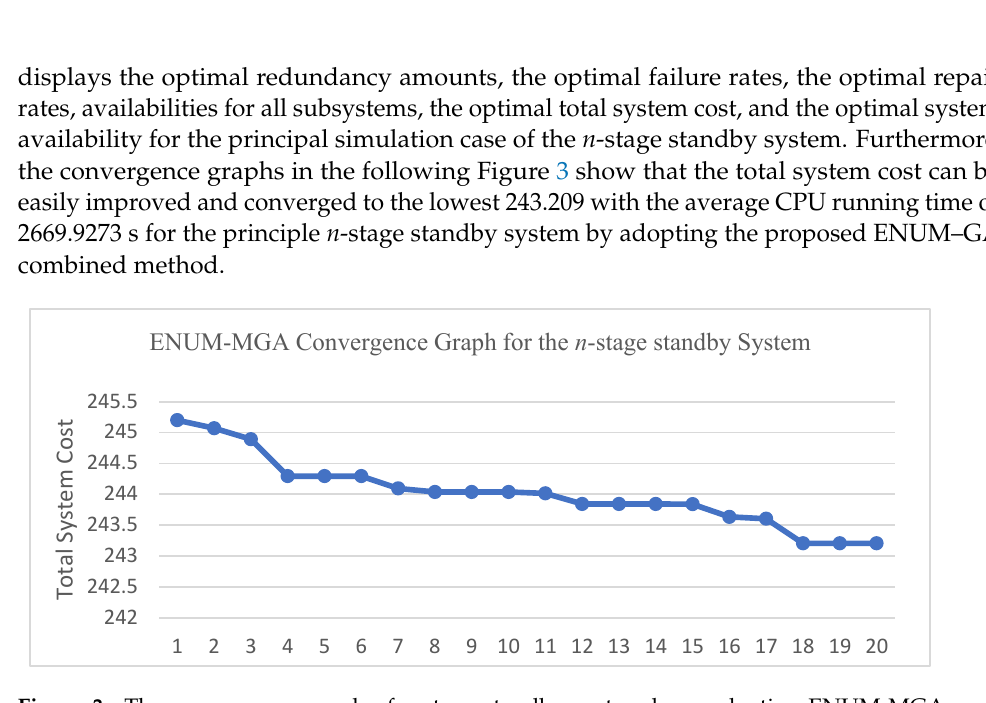
Figure 3. The convergence graph of n -stage standby system by conducting ENUM-MGA combined method.